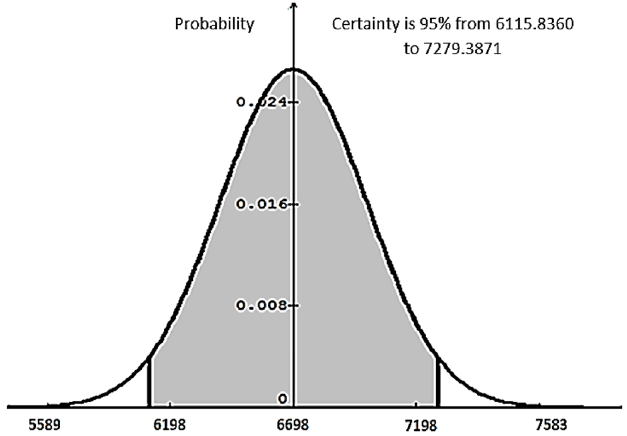
Fig. 6. Result of the Monte Carlo